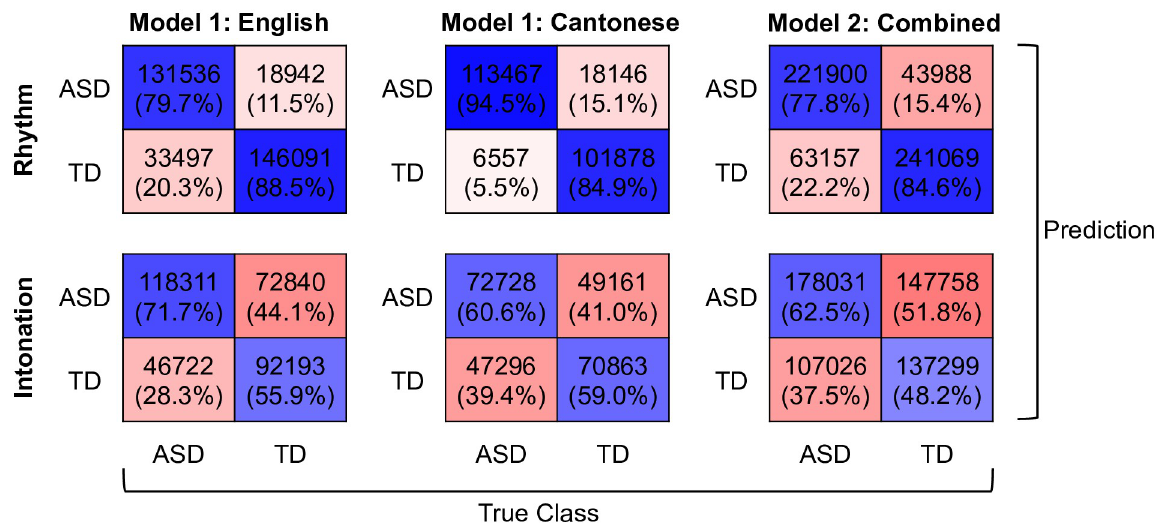
Fig 2. Confusion matrices. Confusion Matrices of machine learning classifications in Model 1 (English and Cantonese) and Model 2 (Combined), aggregated across all 5001 iterations of cross-validation in each classification. Blue hues: correct predictions; Red hues: incorrect